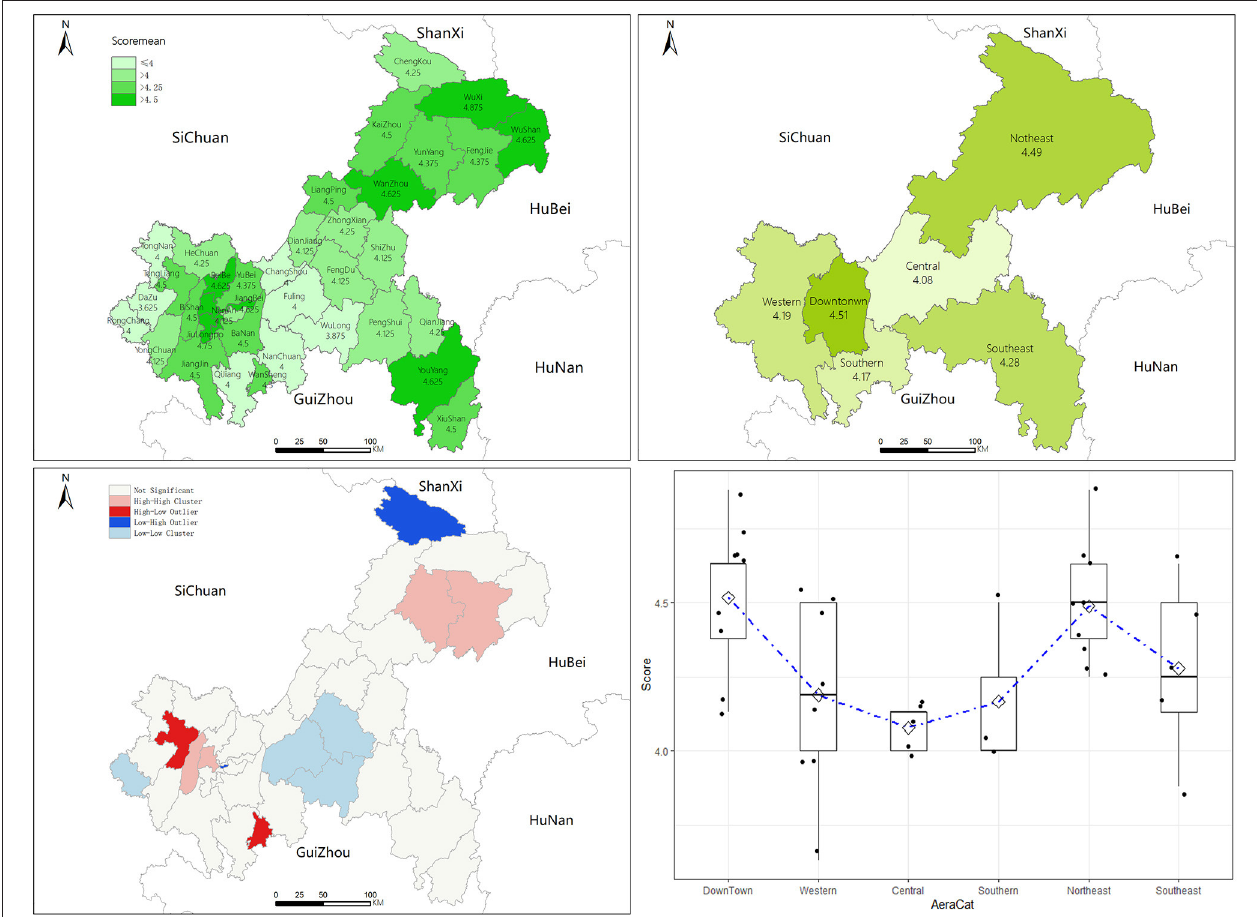
FIGURE 1 | Geographic information analysis map and statistical analysis chart of the test scores.